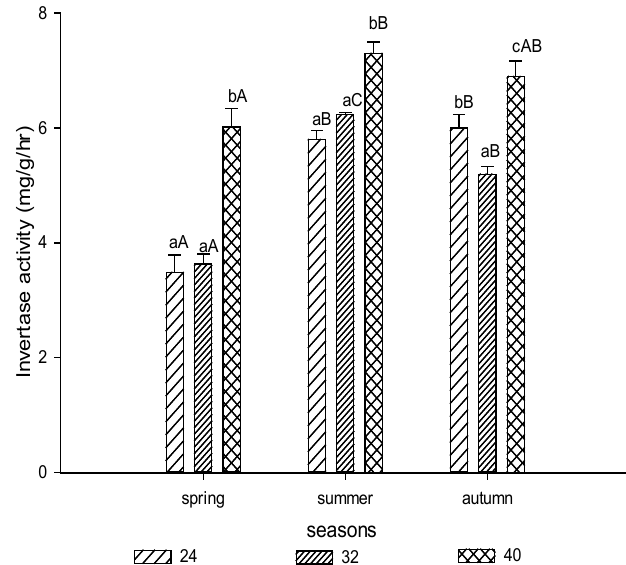
Figure 1. Influence of time since thinning (24, 32 and 40 years) and season on soil invertase activity. Capital letters indicate statistically significant differences among season within each time since thinning; lowercase letters indicate statistically significant differences among times since thinning within the same season. Bars indicate the standard error of the mean.